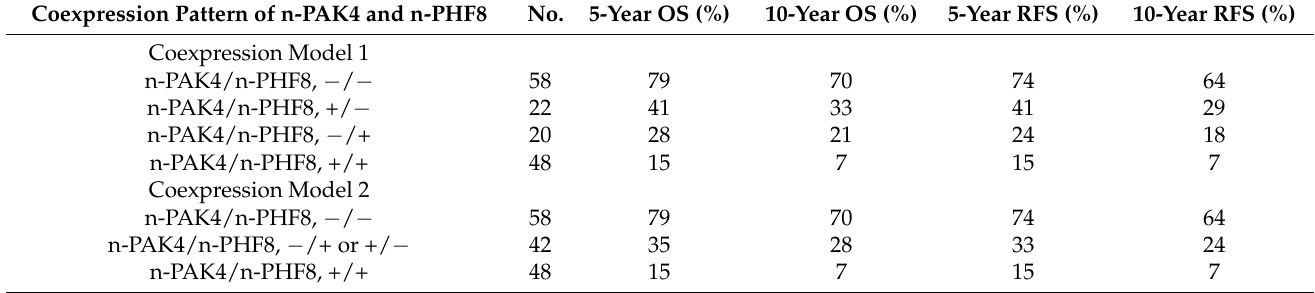
Table 4. Five- and ten-year survival according to coexpression patterns of n-PAK4 and n-PHF8 in GBCs.